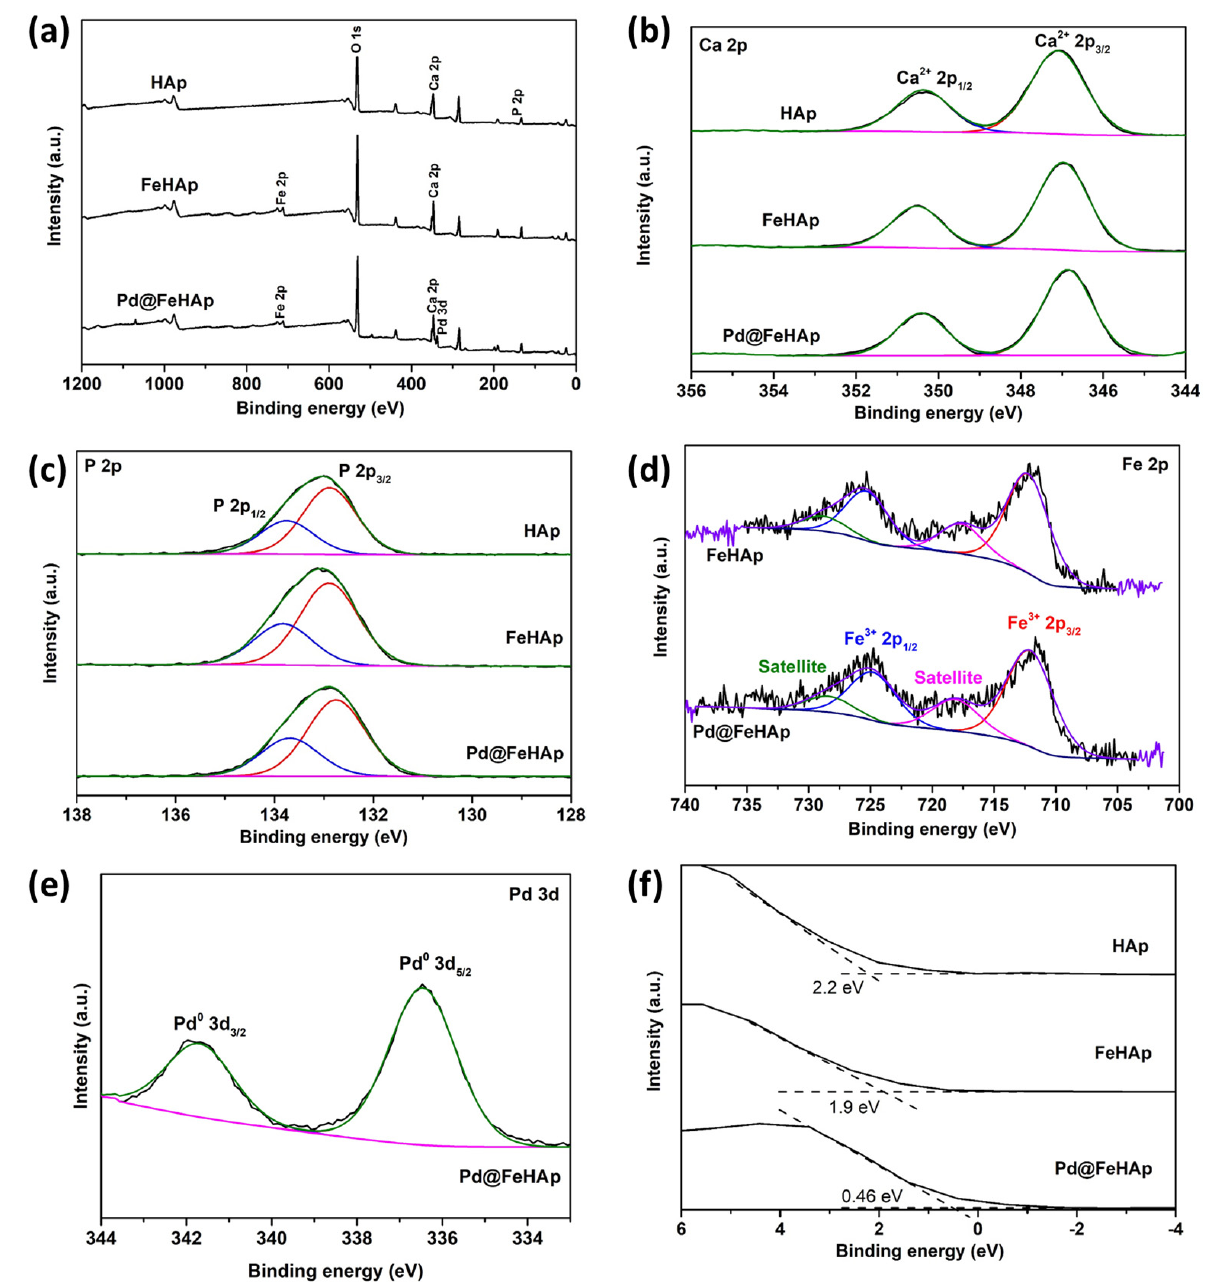
Figure 5. XPS spectra of HAp, FeHAp, and Pd@FeHAp: ( a ) survey spectra, ( b ) Ca 2p, ( c ) P 2p, ( d ) Fe 2p, ( e ) Pd 3d, and ( f ) valence band energy region.